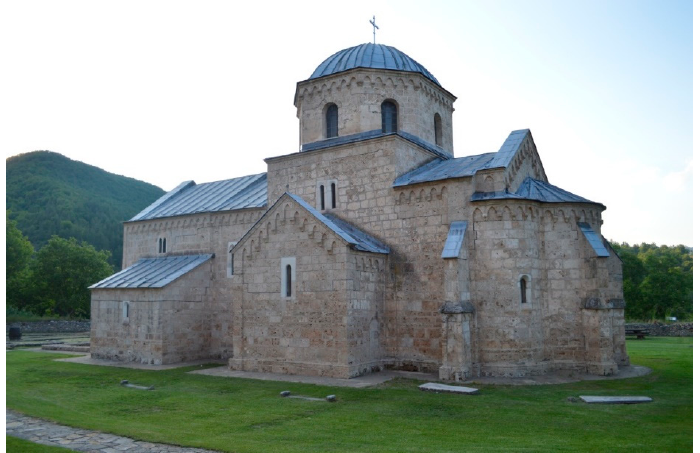
Figure 3. Annunciation Church of Gradac Monastery, endowment of Queen Helen, built around 1275. Photo Č edomila Marinkovi ć .